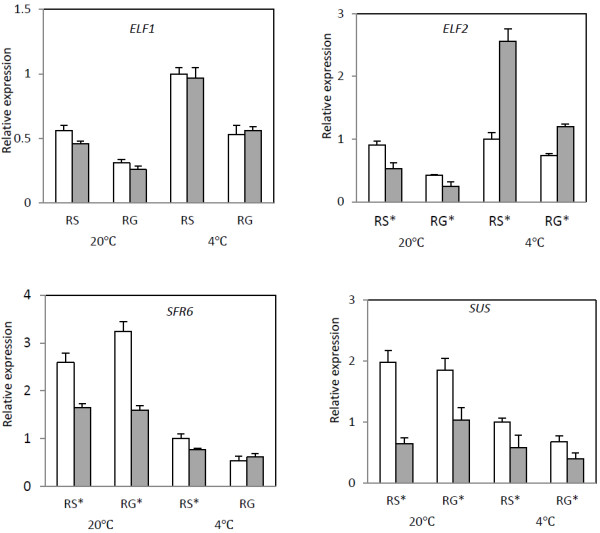
Paris polyphylla var. yunnannsis seed (Em, embryo; En, endosperm; Co, cotyledon; Hy, hypocotyls; Ra, radical). A, the ovule 130d after fertilization; B, Freshly harvested seed not at full development (dyed with tetrazole); C, D, Radicle sprout testa after about 60d stratification.